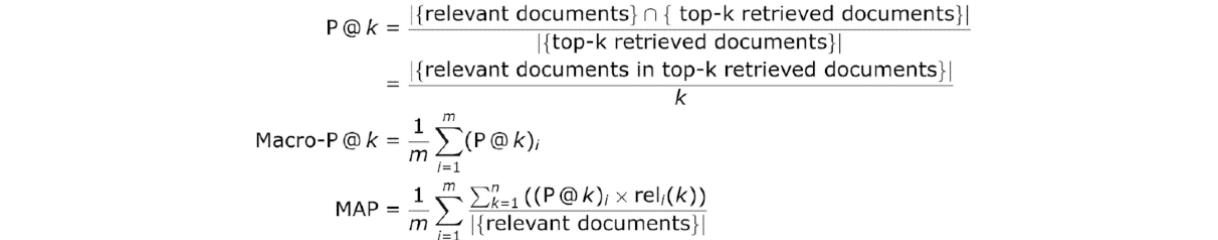
Figure 7. Evaluation metrics of recommendation